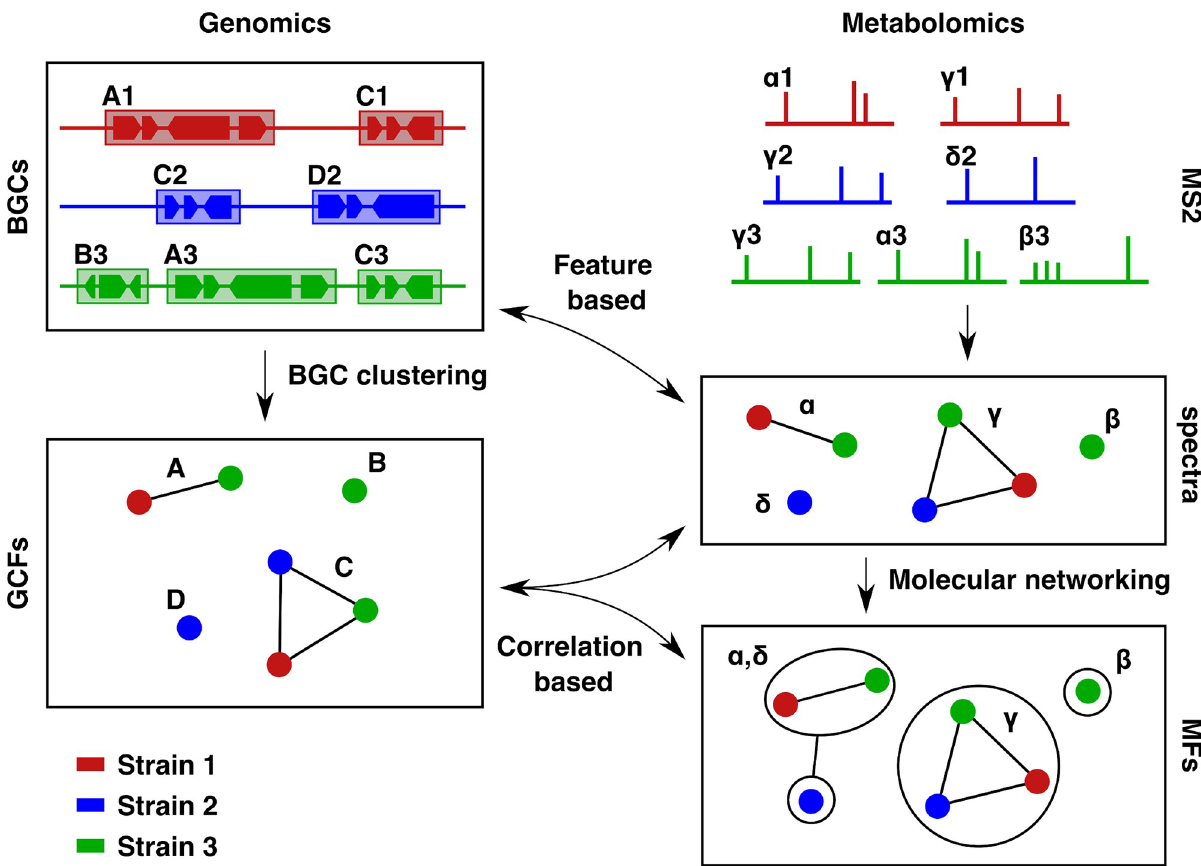
Fig 1. Diagram showing the relationship between the various metabolomic and genomic objects. On the genomics side, BGCs are detected from microbial genomes, colour-coded by strain. These are clustered into GCFs, where each GCF contains BGCs from one or more strains. GCFs can thus also be considered as sets of strains, where each strain contributes at least one BGC to the GCF. On the metabolomics side, MS2 spectra measured in microbial cultures are grouped across strains, so that identical spectra are assigned one or more strains in which they appear. These are further grouped into MFs in a process called Molecular Networking, where each MF consists of one or more related spectra. Both spectra and MFs can likewise be considered as sets of strains where the spectrum, or a spectrum in the MF, is present in the sample for the strain. Feature-based approaches can be